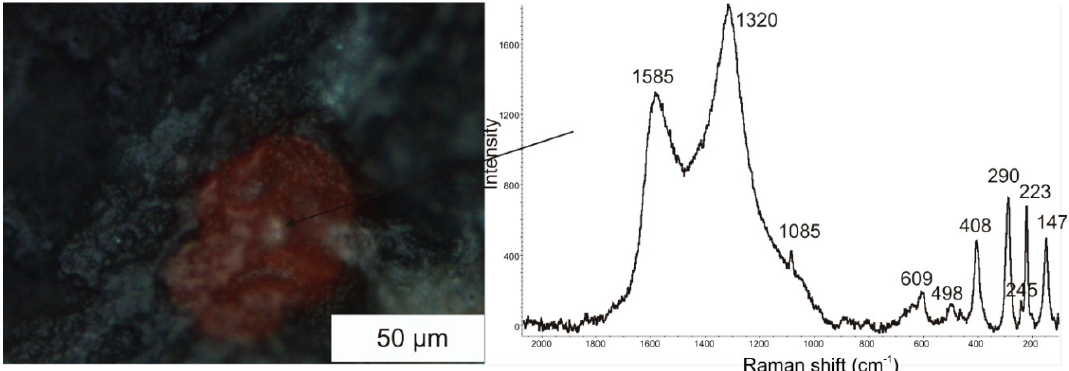
Figure 6. Microphoto of complex inclusion of hematite, calcite, and organic substance in agate with the related Raman bands.